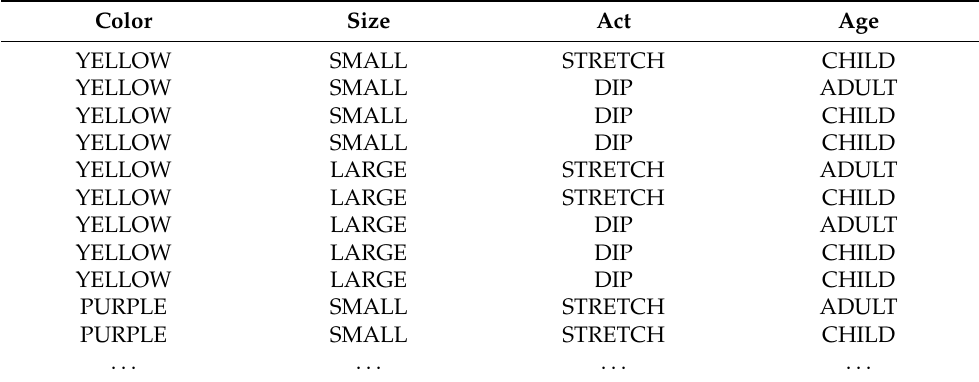
Table 1. A snapshot of the Balloons Dataset. We omitted the class attribute since it is not used for